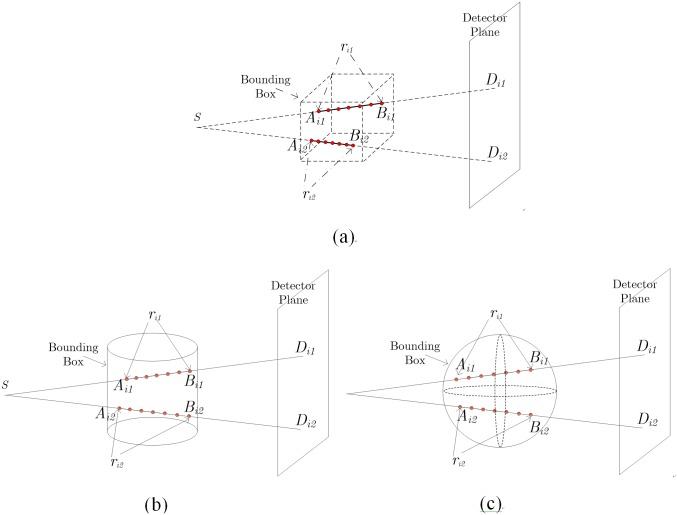
Non-uniform distributed samples points in projection geometry.(a) cubic FOV, (b) cylinder FOV, (c) sphere FOV